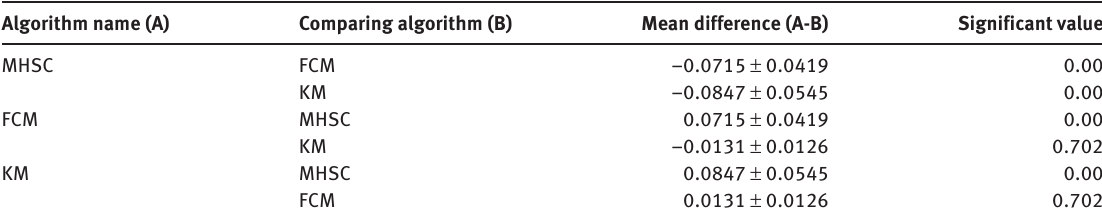
Table 6: Estimated Means and Pairwise Comparisons of Different Algorithms on the Minkowski Score Obtained by ANOVA Testing for the Iris